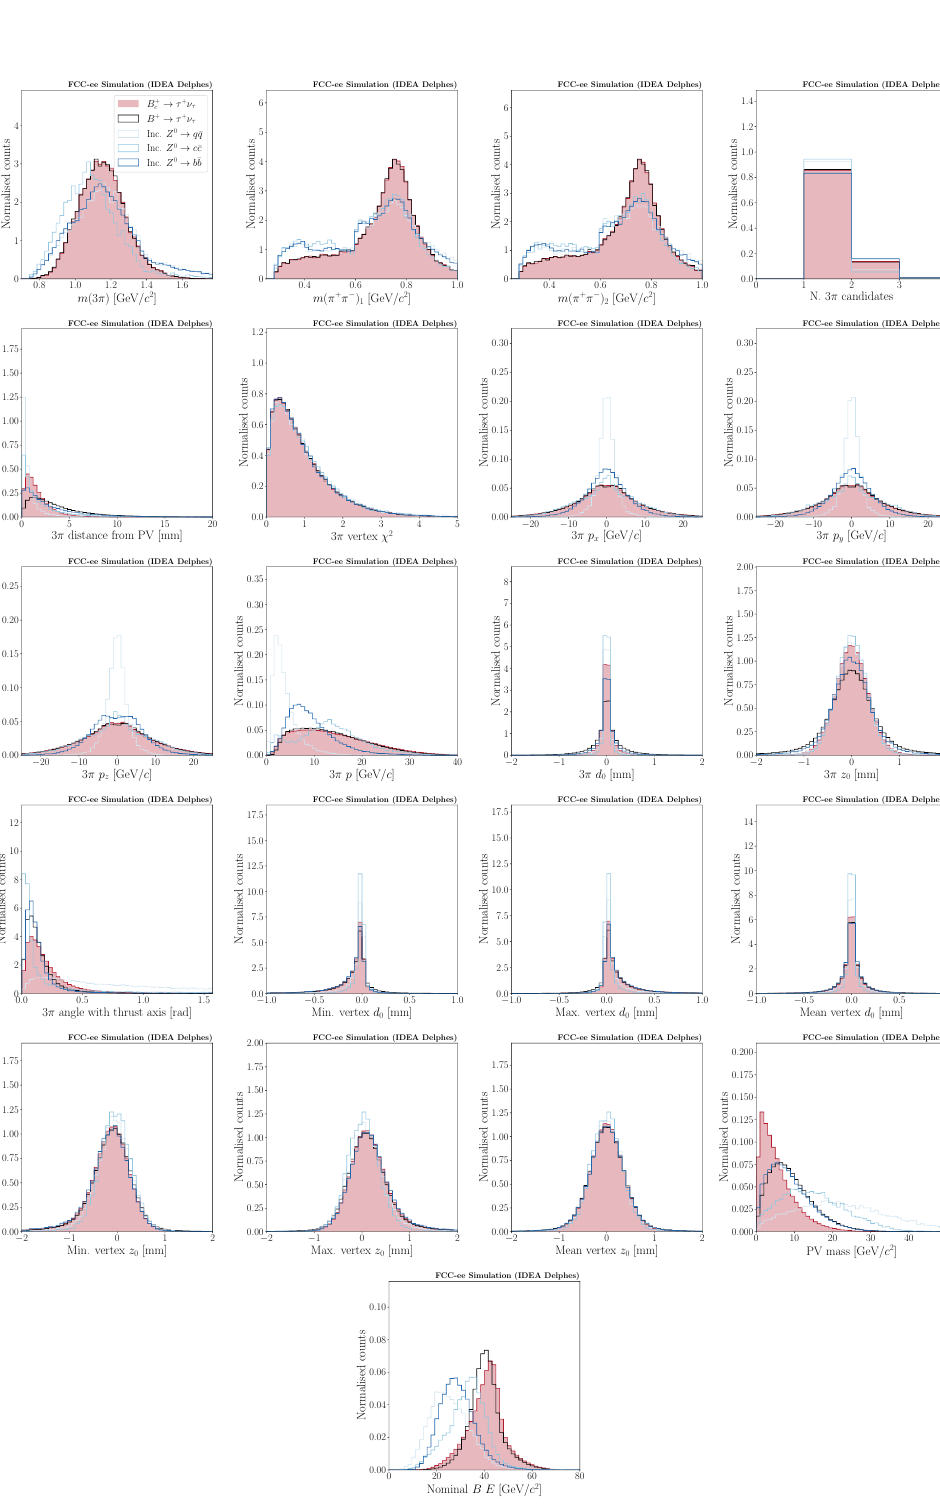
Figure 13 . Second-stage BDT training variable distributions in signal, B + → τ + ν τ background, and inclusive Z 0 → q ¯ q, c ¯ c, b ¯ b